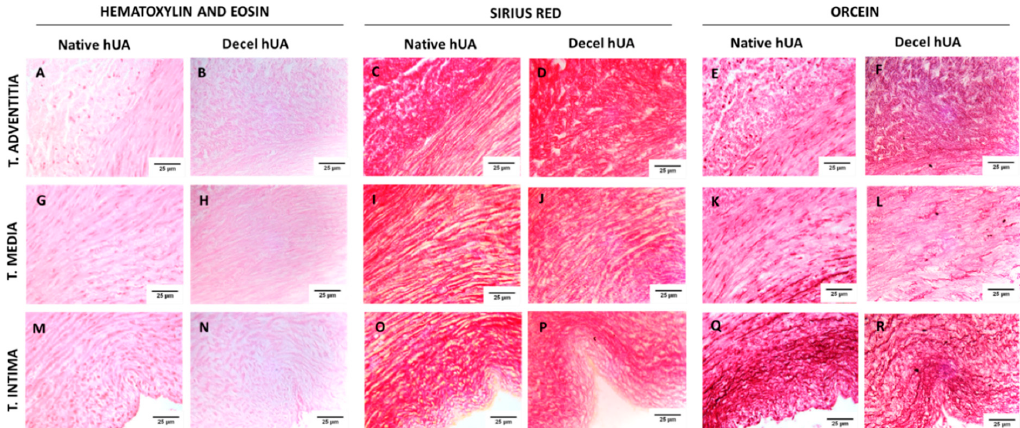
Figure 2. Multilayer histological analysis of human umbilical arteries (hUAs). Tunica adventitia of native and decellularized (decel) hUA stained with Hematoxylin and Eosin (H&E) ( A , B ), Sirius Red (SR) ( C , D ), and orcein stain (OS) ( E , F ), respectively. Tunica media of native and decellularized hUA stained with H&E ( G , H ), SR ( I , J ), and OS ( K , L ), respectively. Tunica intima of native and decellularized hUA stained with H&E ( M , N ), SR ( O , P ), and OS ( Q , R ), respectively. Images were acquired with 40× original magnification and scale bars 25 μ m.